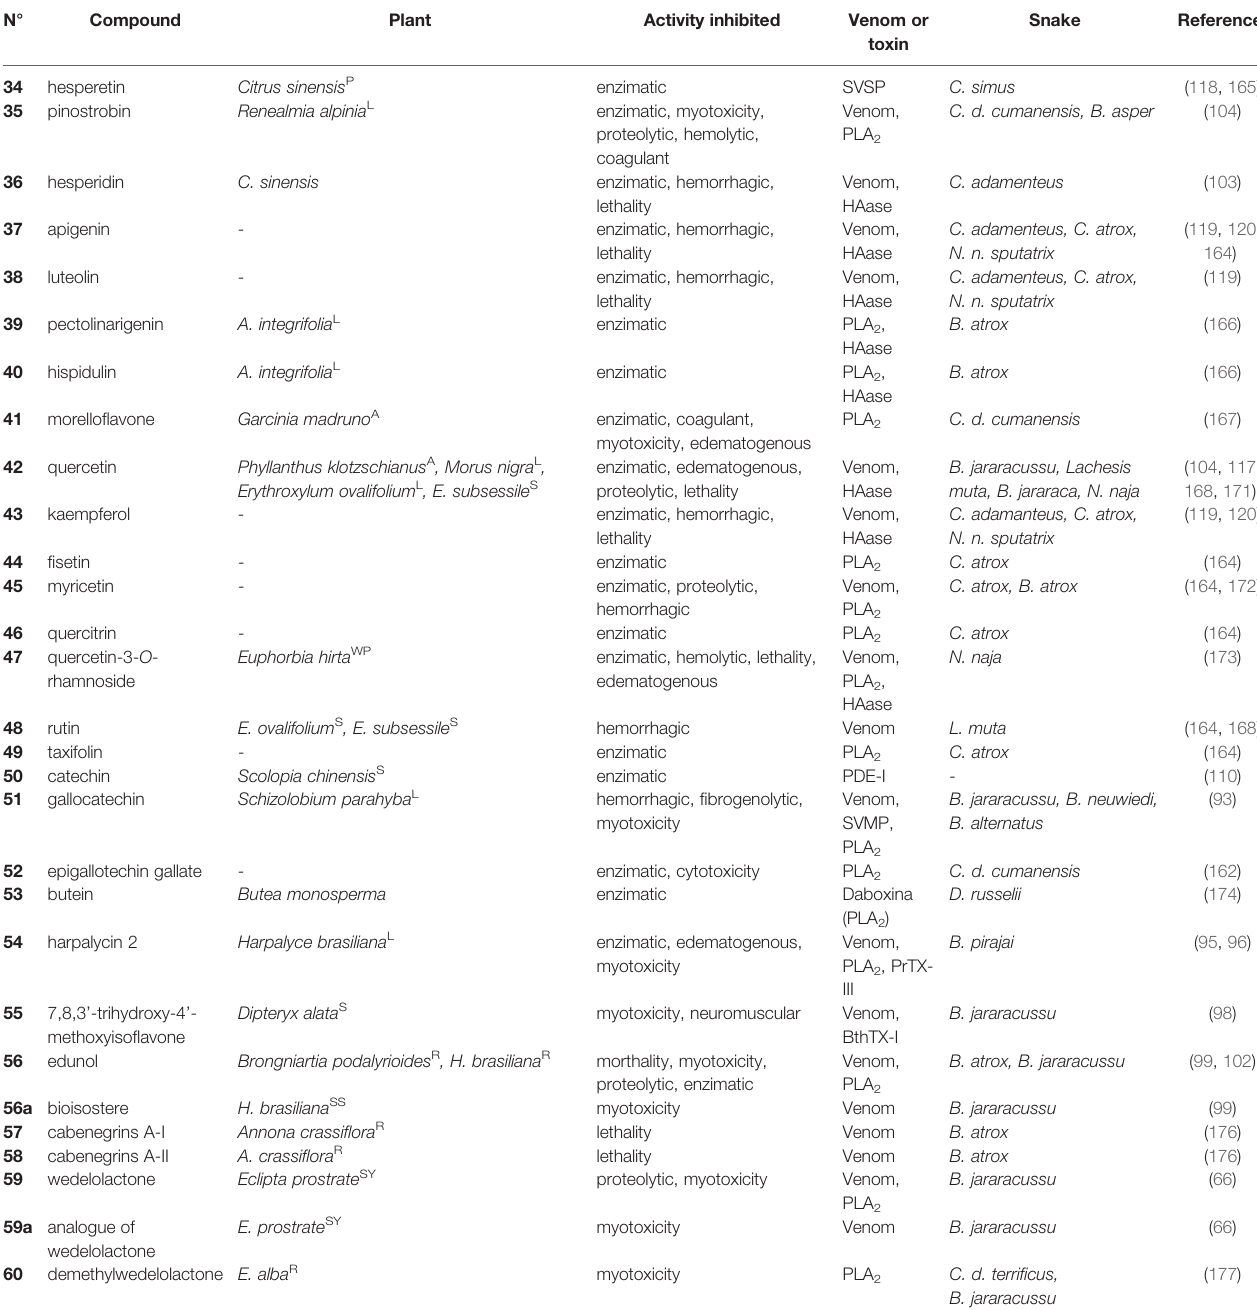
TABLE 3 | Flavonoids (34-53) and iso fl avonoids and derivates (54-60) with antivenom